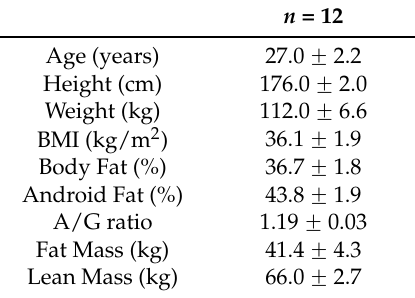
Table 1. Descriptive